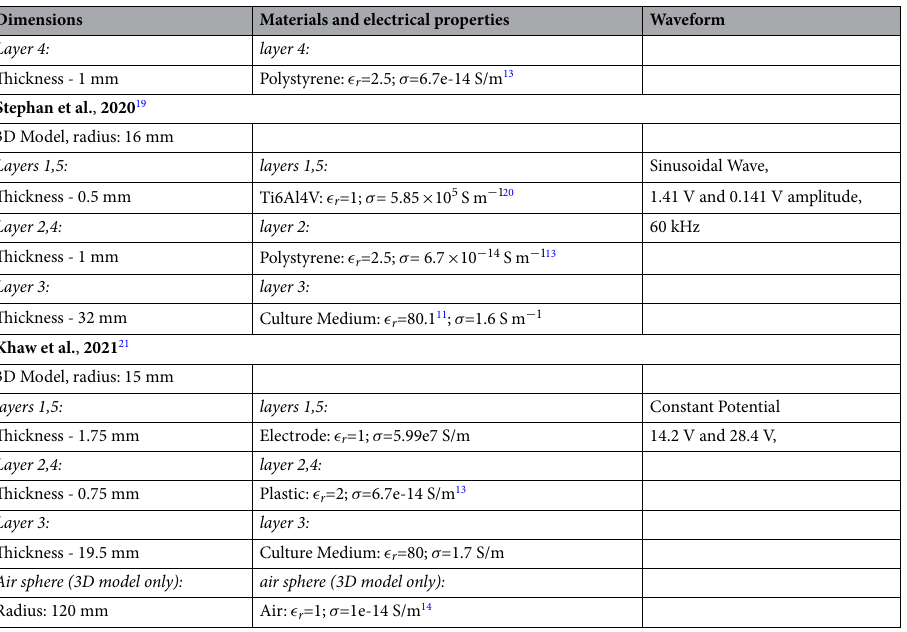
Table 1. Dimensions, electrical properties and waveforms for the setups modelled. ǫ r is the relative permittivity, σ is the